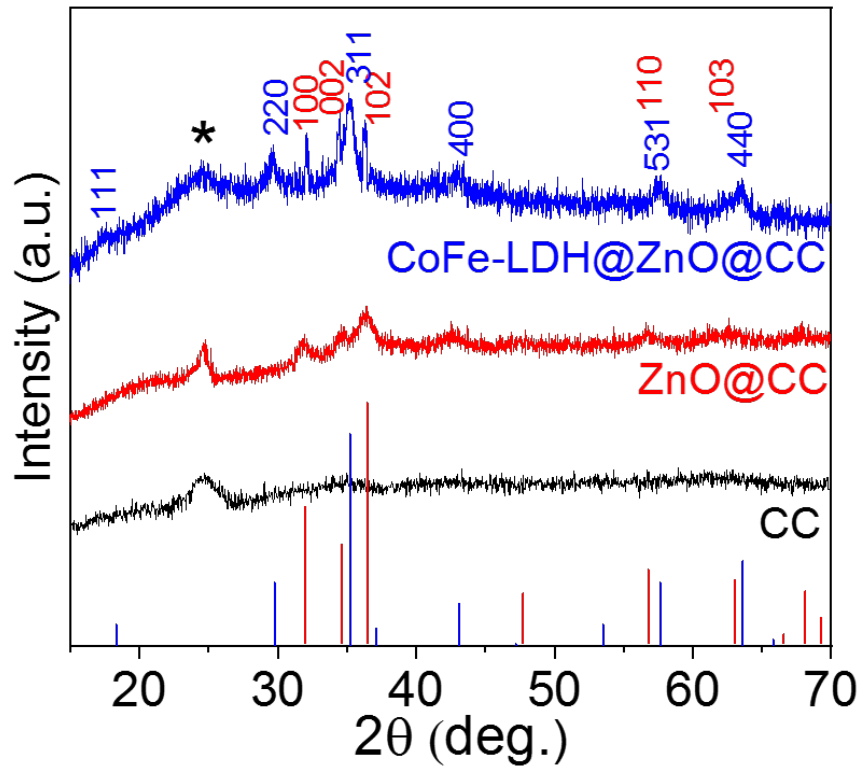
Figure 3. XRD patterns of CC, ZnO@CC, and CoFe-LDH@ZnO@CC (Asterisk denoted the peaks generated form CC).